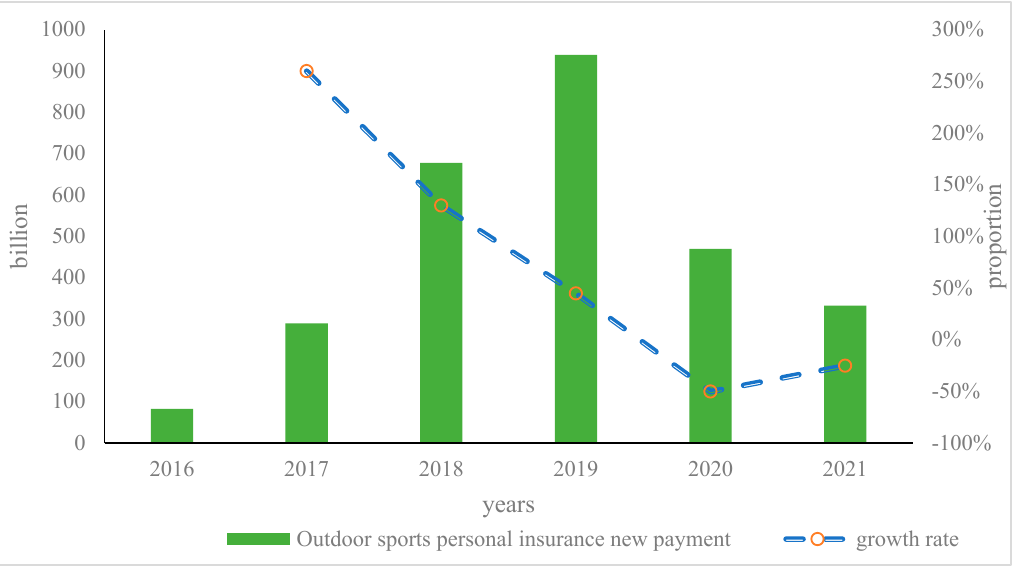
Figure 5. New payment and growth rate of outdoor sports personal insurance.